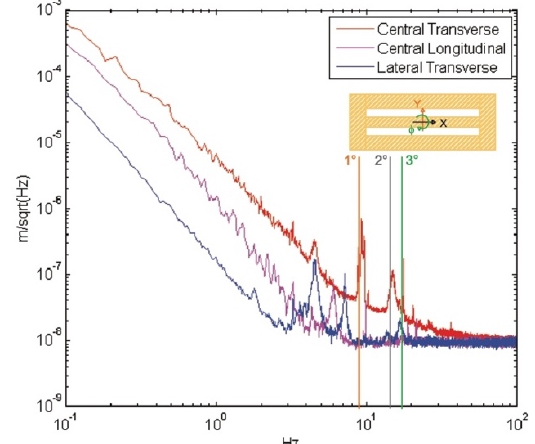
Table 3. Modal analysis results, Case 1